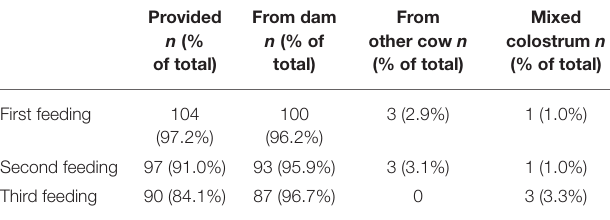
TABLE 2 | Sources of colostrum fed to the most recently born calf.